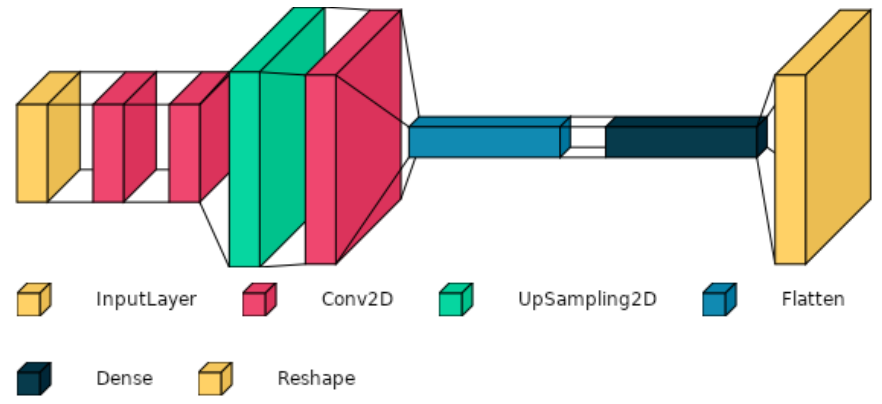
Figure 3. The model of the convolutional neural network used for sinogram